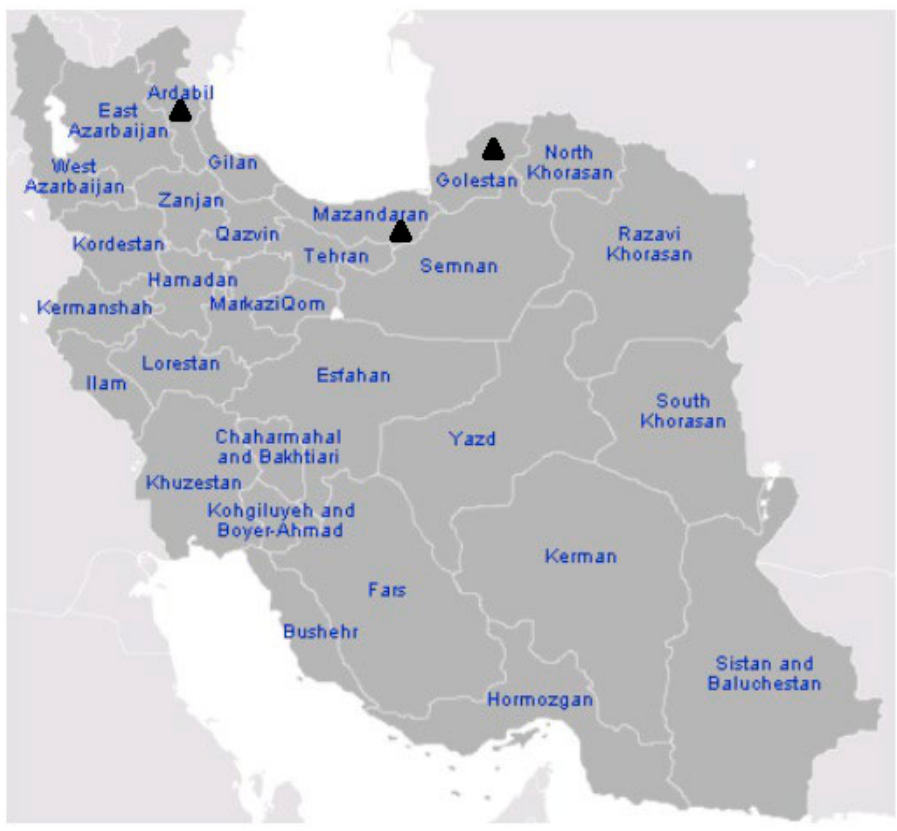
Figure 1. Map of Iran with provinces where Fusarium culmorum isolates were collected ( ▲